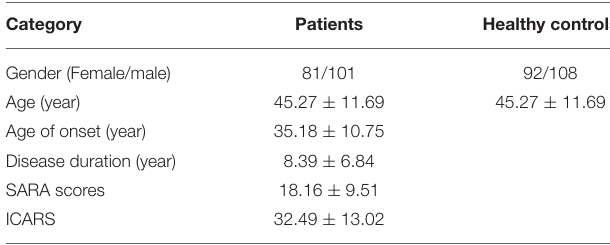
TABLE 1 | The clinical evaluations of all the